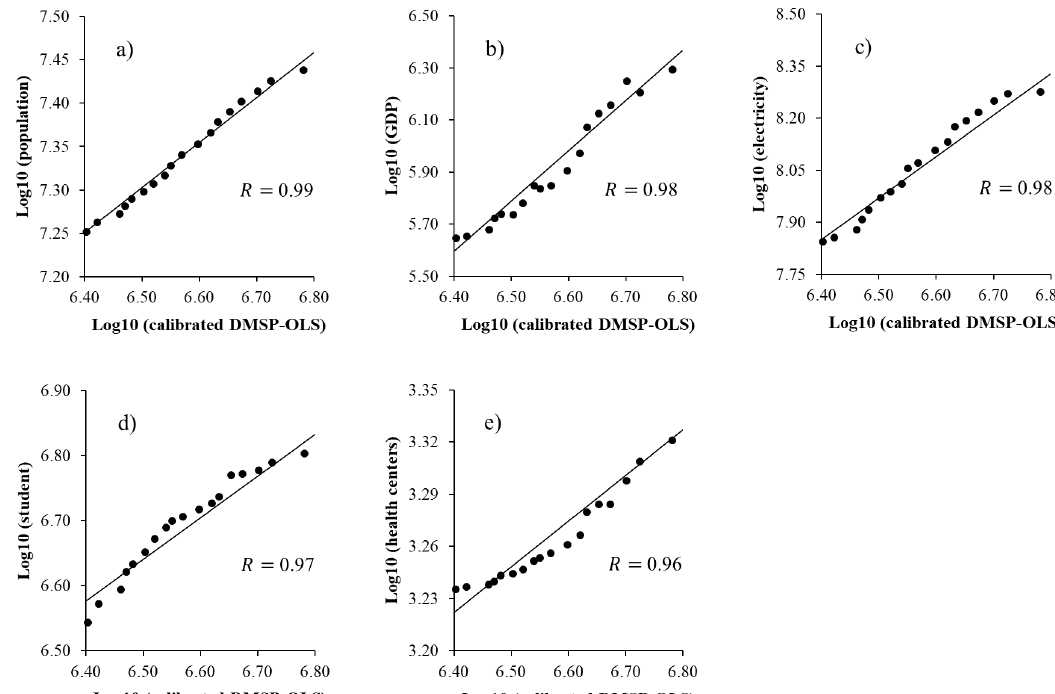
Figure 6. Correlation of the log of ( a ) population, ( b ) GDP, ( c ) electricity consumption, ( d ) number of students and ( e ) number of health centers on the log of calibrated DMSP-OLS SNT data in Saudi Arabia.